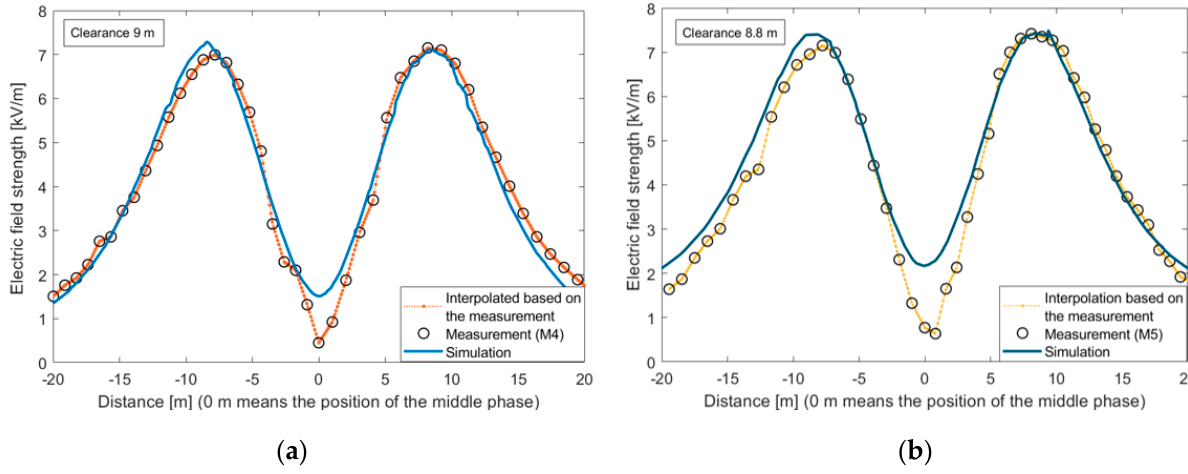
Figure 4. Comparing simulated and measured electric field distribution. ( a ) M4 measurement curve and E-field simulation at clearance 9 m; ( b ) M5 measurement curve and E-field simulation at clearance 8.8 m.